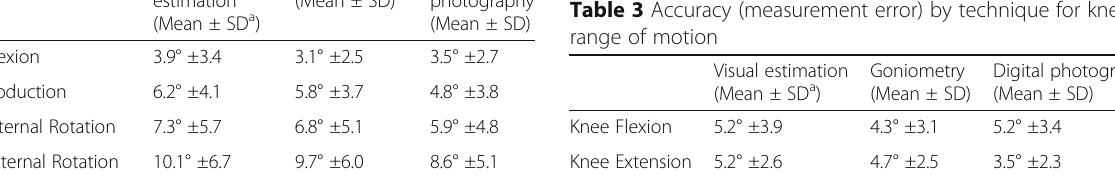
Table 3 Accuracy (measurement error) by technique for